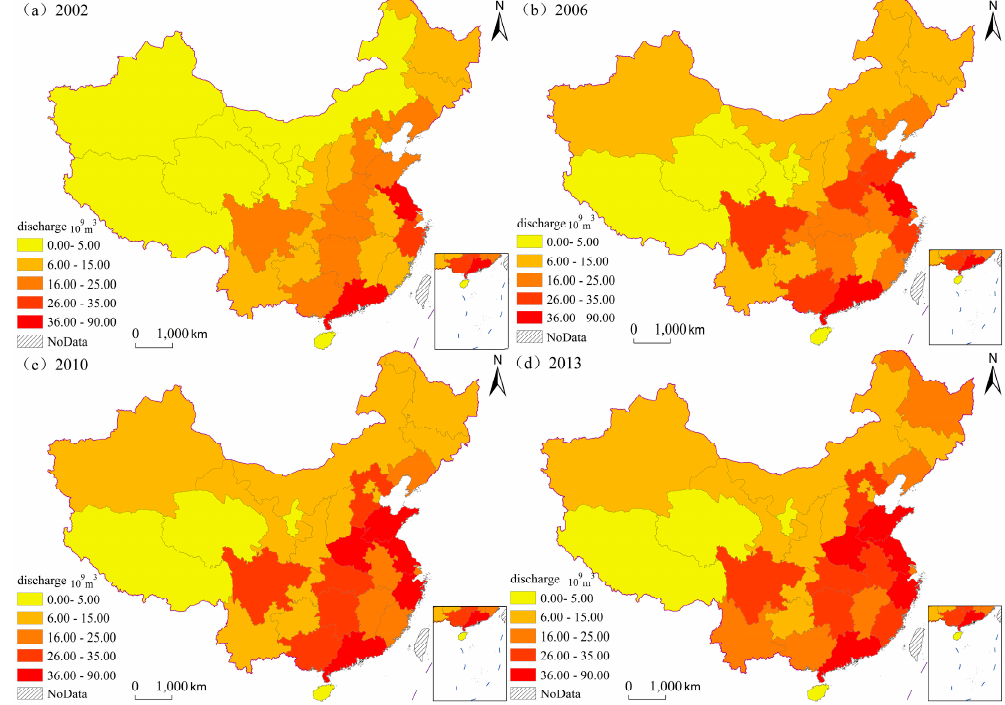
Figure 3. Distribution of wastewater discharge at national level in China, 2002–2013.